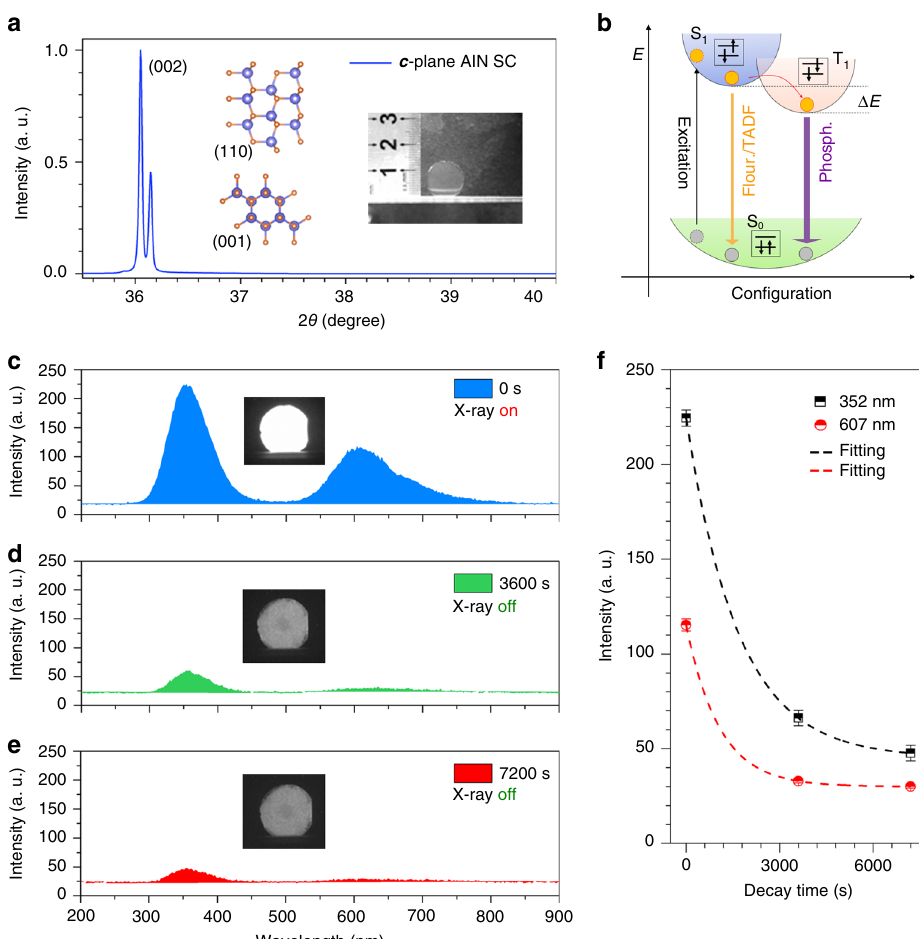
Fig. 1 Crystal structure and phosphorescence of AlN SCs. a XRD pattern of AlN SC shows obvious characteristic (002) peak (k α 2 peak). The insets show the crystal structure viewed on (110) and (001) faces; N atoms and Al atoms are in orange and blue, respectively. The optical photograph shows a sample of AlN SCs with the diameter of about 15 mm. b Displacement coordinate schematic of phosphorescence emission. Ground state (S 0 ) electrons are excited into singlet excited state (S 1 ) and the electrons in S 1 state transit to triplet excited state (T 1 ) by obtaining an intersystem crossing energy of Δ E . The transitions from S 1 to S 0 usually emit fl uorescence (Fluor.) and thermal-active delay fl uorescence (TADF), and from T 1 to S 0 the transitions emit long-living phosphorescence (Phosph.). The phosphorescence spectra of AlN SCs after X-ray excitation for 0 s ( c ), 3600 s ( d ), and 7200 s ( e ) is compared. The insets show corresponding optical photographs collected by a UV-sensitive iCCD detector. f PL intensity plots with decay time show that the time evolution of UV and yellow phosphorescence matches well with exponential decay